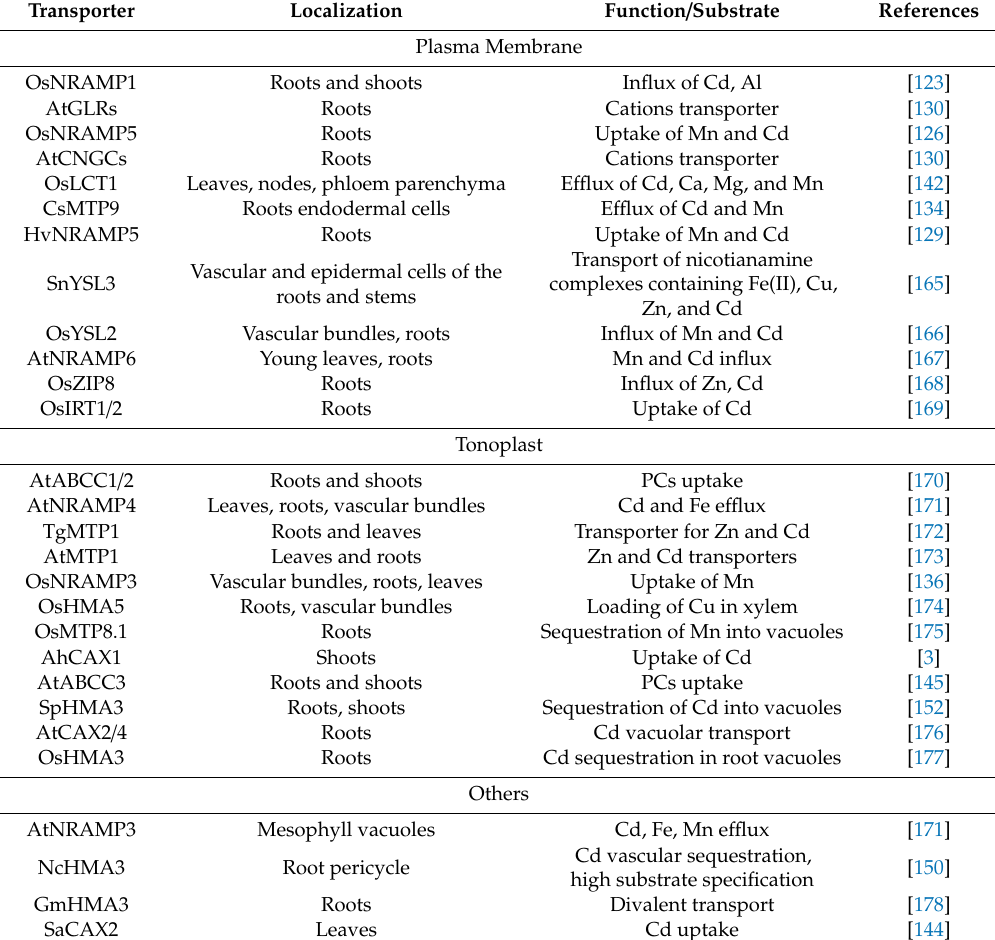
Table 2. Summary of Cd transporters; their localization and function in